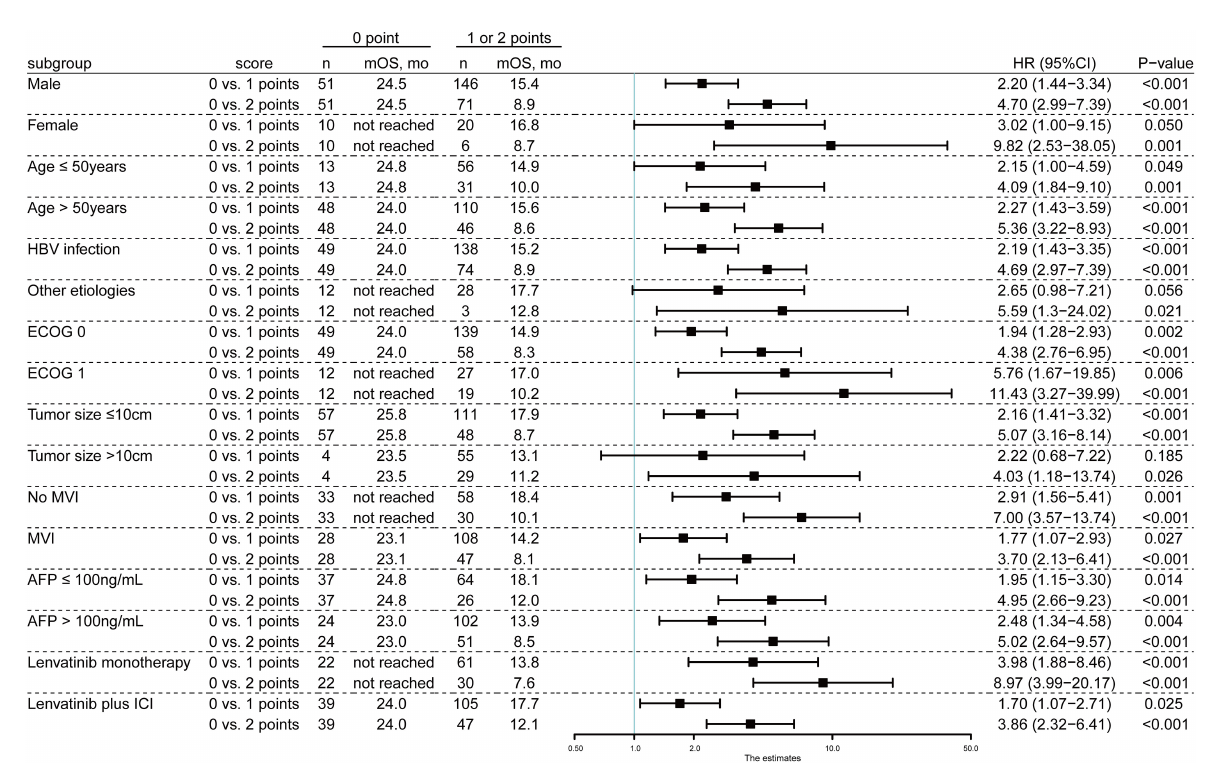
FIGURE 3 The prognostic ef fi ciency of PIMET score in subgroups of patients receiving lenvatinib monotherapy or lenvatinib plus ICI for unresectable HCC. Median OS (Kaplan-Meier method) and hazard ratios (univariable Cox regression) for death comparing PIMET categories (0 vs. 1 and 0 vs. 2 points) in different subgroups in the whole cohort. AFP, alpha-fetoprotein; CI, con fi dence interval; ECOG, Eastern Cooperative Oncology Group performance status; HBV, hepatitis B virus; HCC, hepatocellular carcinoma; HR, hazard ratio; ICI, immune checkpoint inhibitor; mOS, median overall survival; MVI, macrovascular